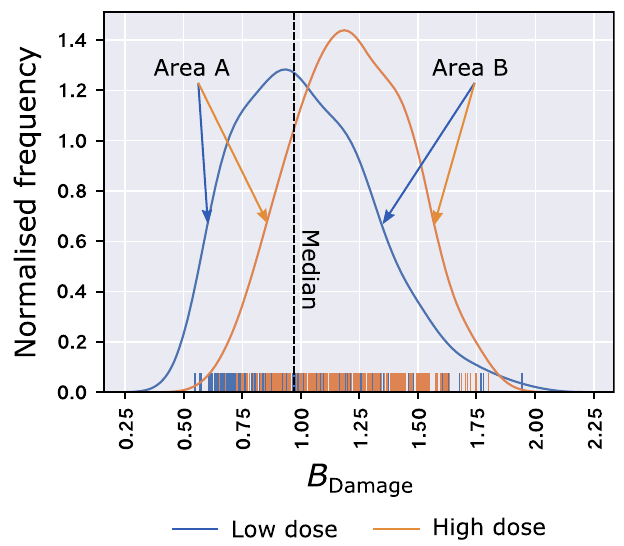
Fig. 2 Calculation of the B net metric. The B net metric is calculated from the kernel density estimate of the B Damage values of a structure ’ s aspartate and glutamate side-chain oxygen atoms as the ratio of the area under the curve on either side of the median B Damage value of all atoms in the structure. Displayed kernel density estimates and rug plots are of a low (1.11 MGy, PDB accession code 5MCC) and a high (22.7 MGy, PDB accession code 5MCN) dose structure of GH7 family cellobiohydrolase 35 . A and B are the areas under the kernel density estimate of the B Damage -Asp/Glu distribution to the left- and right-hand side of the median B Damage value of all atoms in the structure, respectively. Source data are provided in a Source Data